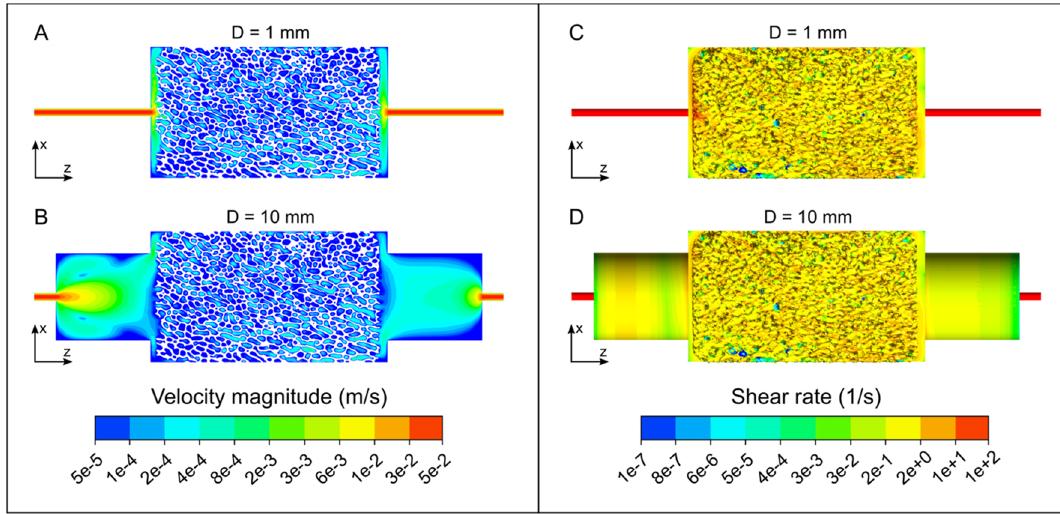
Figure 3. Numerically determined velocity magnitudes in a sectional plane ( A , B ) and shear rates in a cut view ( C , D ) of the bioreactor-scaffold-system with respect to the connector diameters (D = 1 mm, D = 10